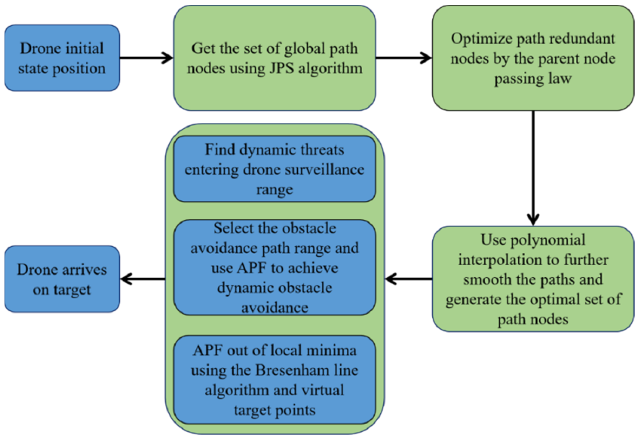
Figure 3. The working framework of this article.